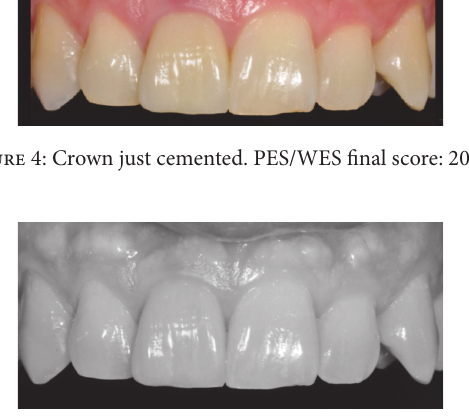
Figure 5: Black and white: checking value.